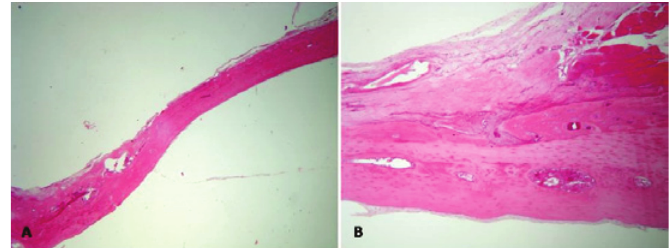
FIGURE 2 – A. Complete bone filling of the bone defect (HE 40x); B. Close up of the bone defect margin and the new bone formation (HE 100x).